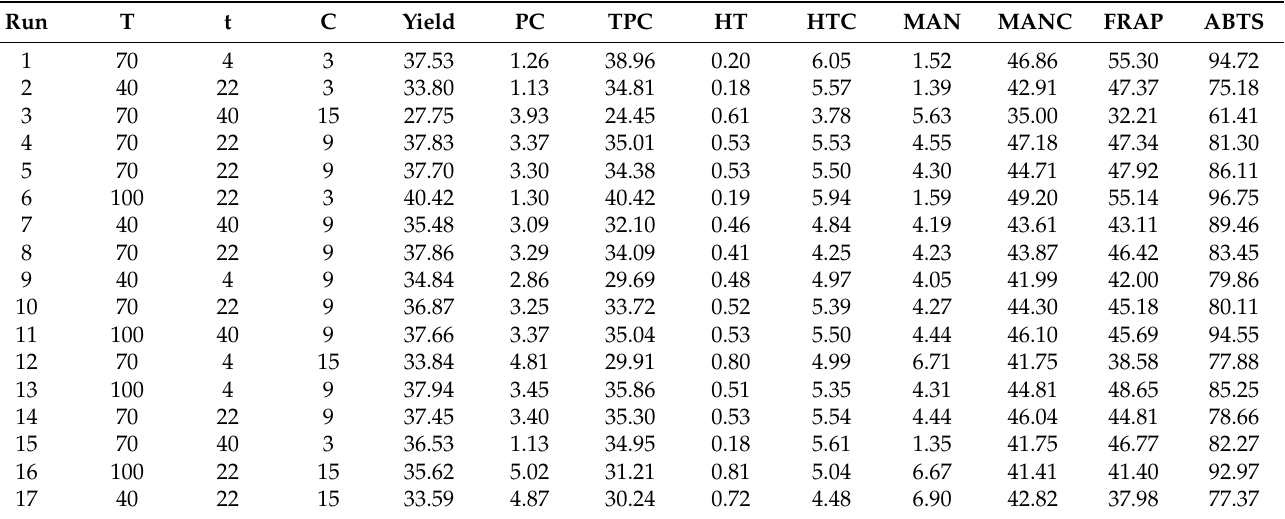
Table 1. Experimental design showing the studied factors (temperature, time, and solid loading) and data obtained for the response